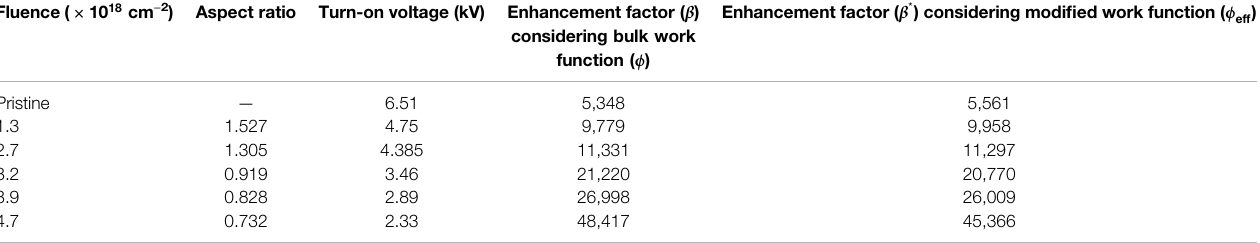
TABLE 2 | A comparison of aspect ratio of structures with turn on voltage and enhancement factor obtained considering bulk and modi fi ed work function, for pristine and irradiated samples. Fluence ( × 10 18 cm − 2 ) Aspect ratio Turn-on voltage (kV) Enhancement factor ( β ) considering bulk